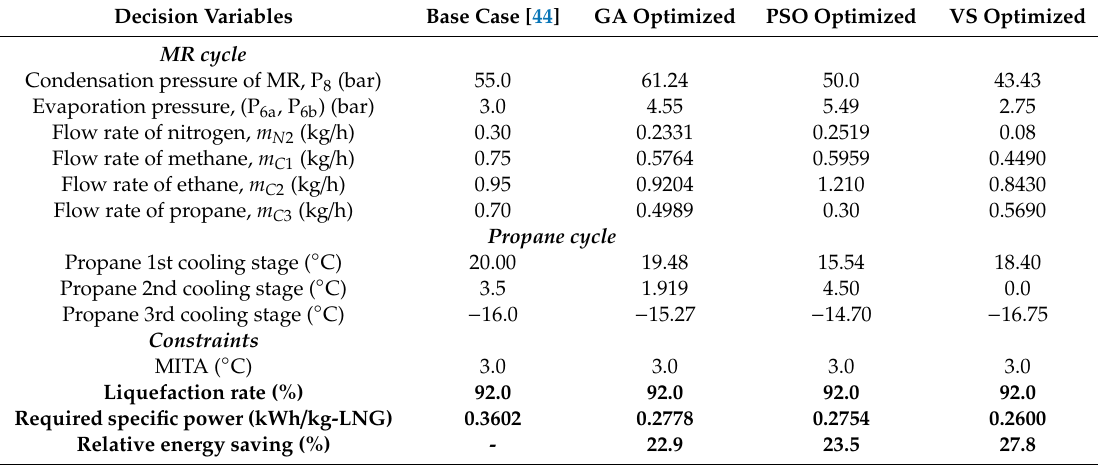
Table 8. Summary and comparison of the optimization results of the VS-optimized C3MR with optimized C3MR process using other well-known optimization